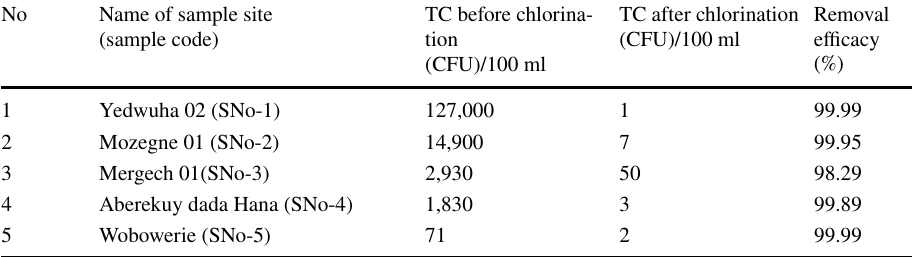
showing before and after chlorination, in Shebel Berenta